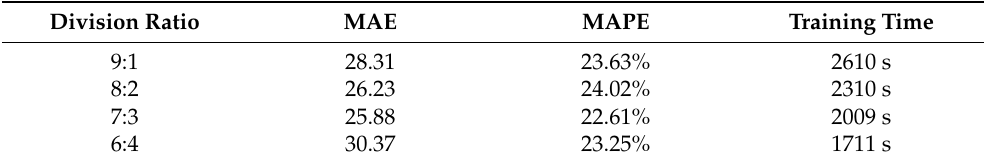
Table 4. Evaluation of model performance with different data division ratio with lstmunits set to 128 and epochs set to 10.